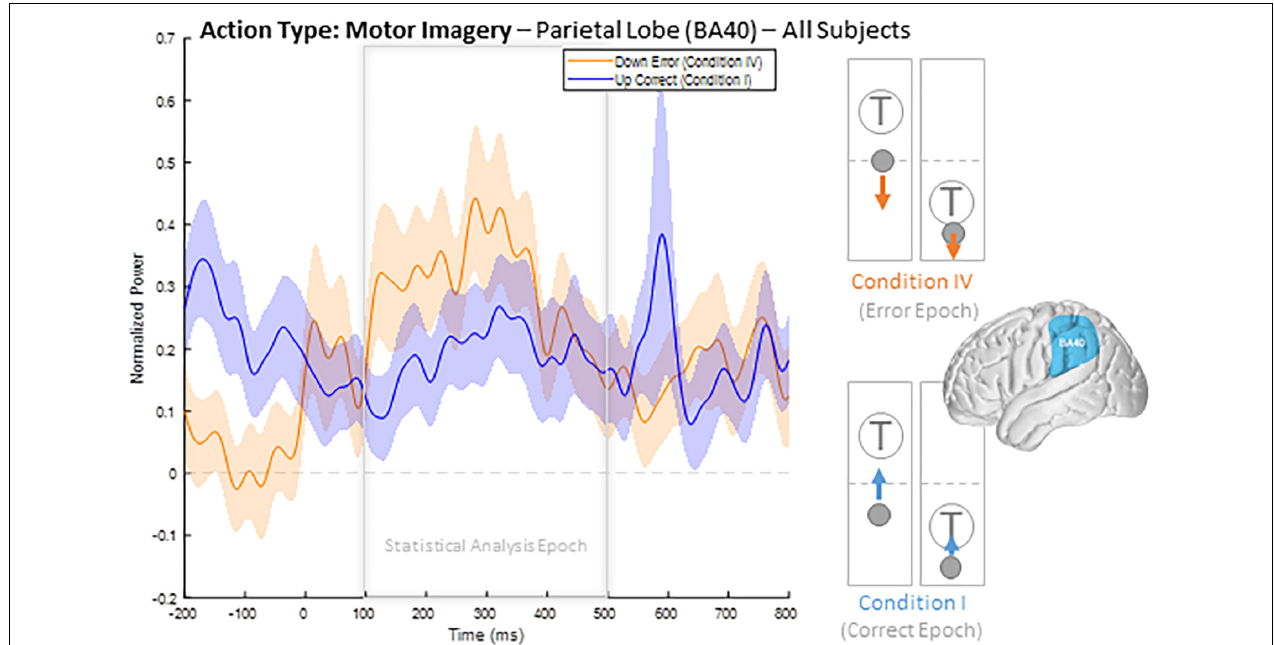
FIGURE 3 | Time series of mean HBP during motor imagery in the decoder error and correct conditions in the parietal lobe (BA 40, highlighted in the brain inset). In these conditions, the subjects were attempting to move the cursor toward the target through eliciting motor imagery. In the erroneous condition, the BCI mistakenly decoded the subject’s intention as wanting to move downwards with rest. Error onset begins at time t = 0 ms for the Condition IV plot. Statistical analyses were performed using the time window of t = 100–500 ms (i.e., the statistical analysis window), as indicated by the window on the figure. Shaded region shows standard error of the mean. Dashed gray line represents